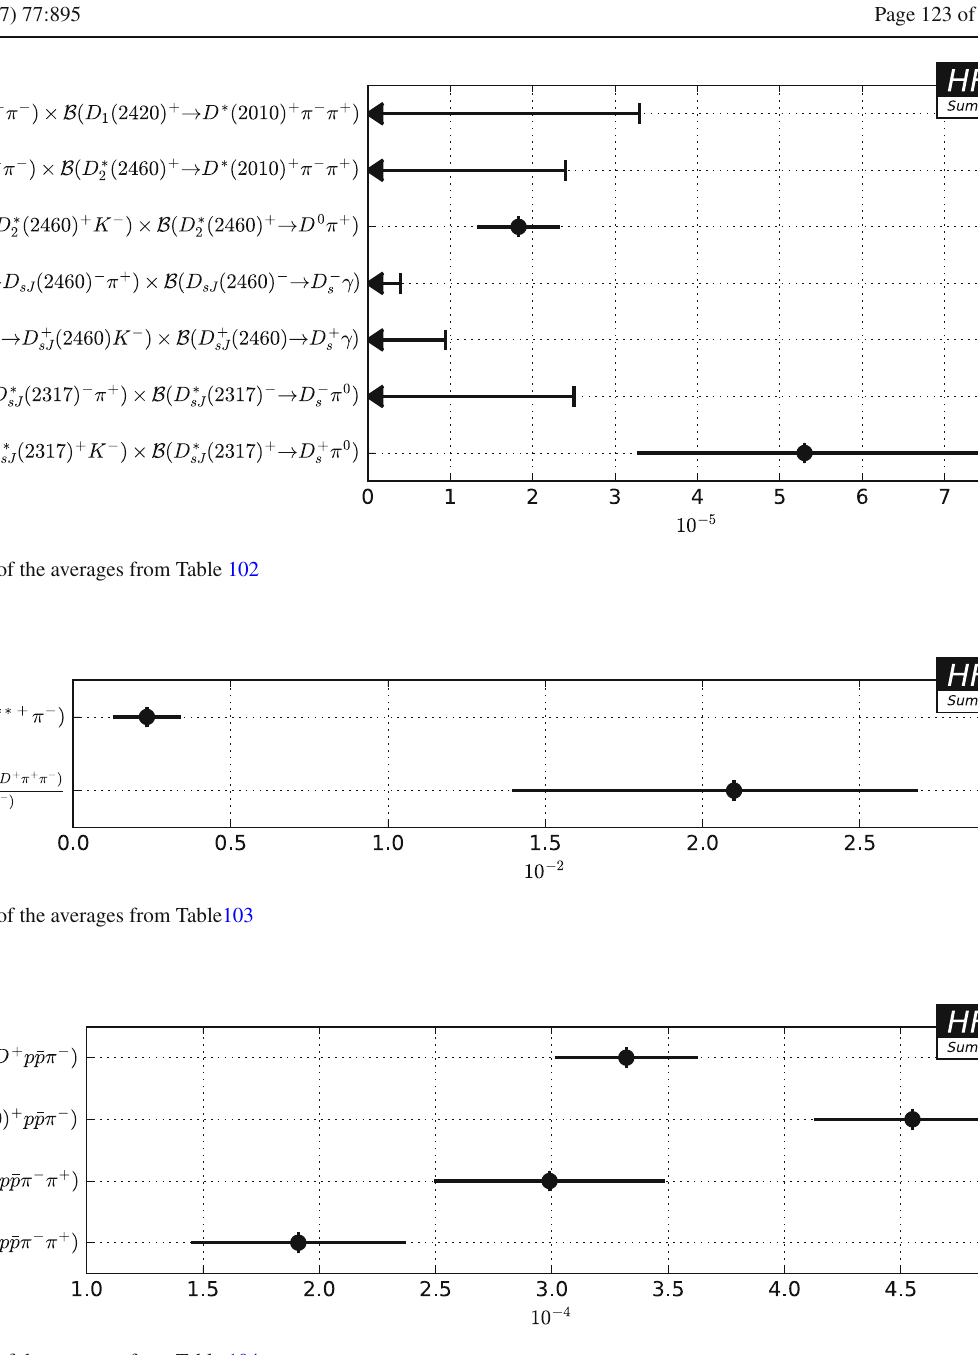
Fig. 79 Summary of the averages from Table